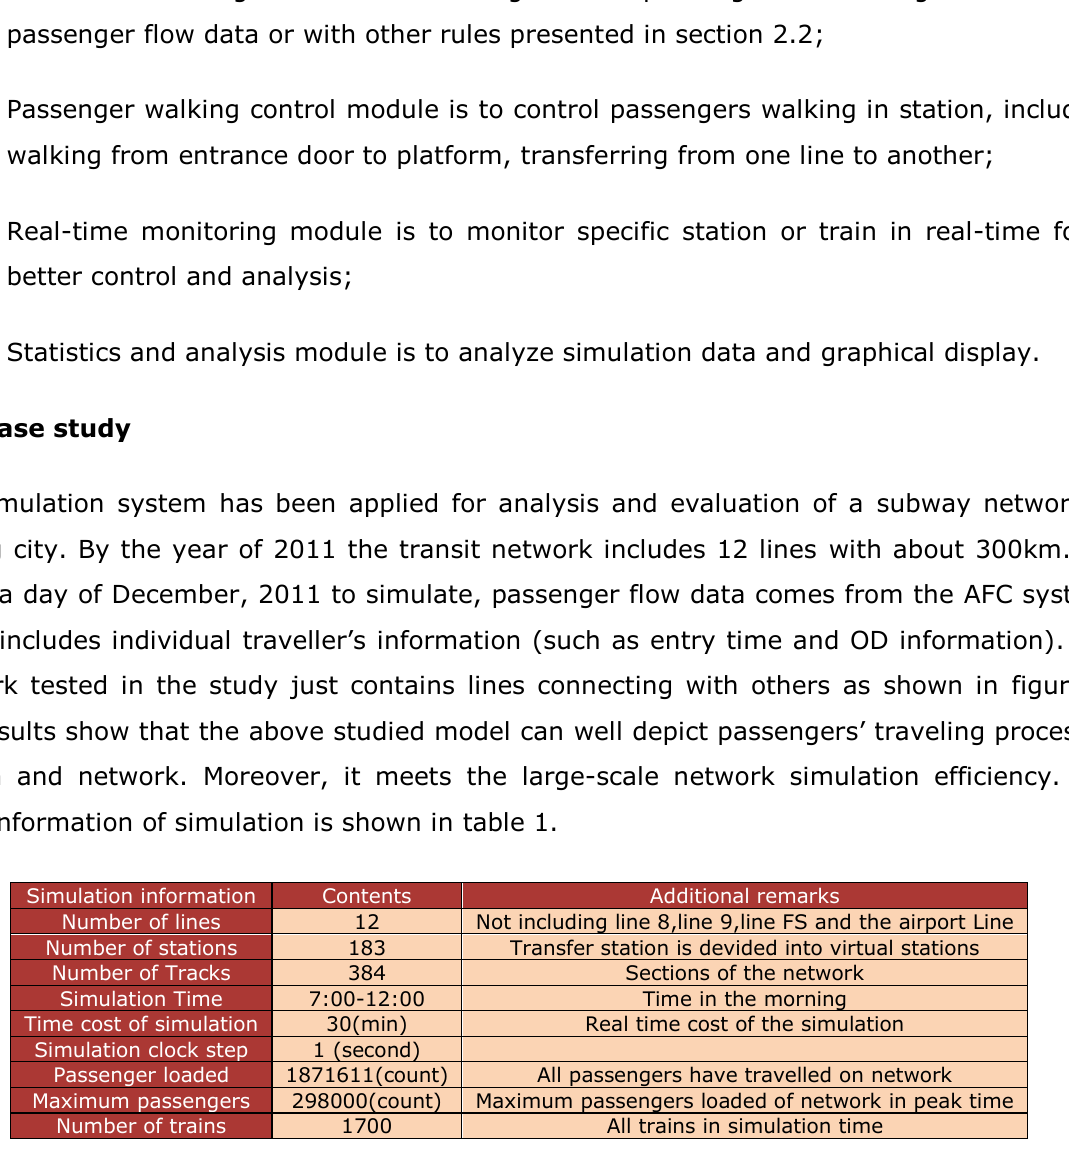
Table 1. Basic information of the